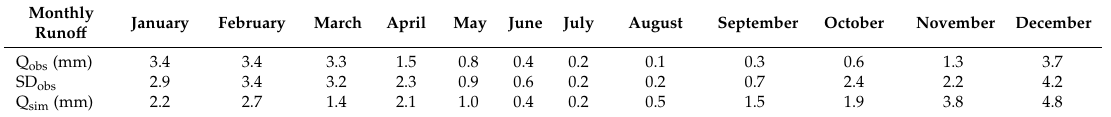
Table 2. Historical monthly runo ff (Q obs ) measured from 1922 to 1964 at the outlet, and relative standard deviation (SD obs ) and simulated monthly runo ff from 1997 to 2006 (Q sim ).